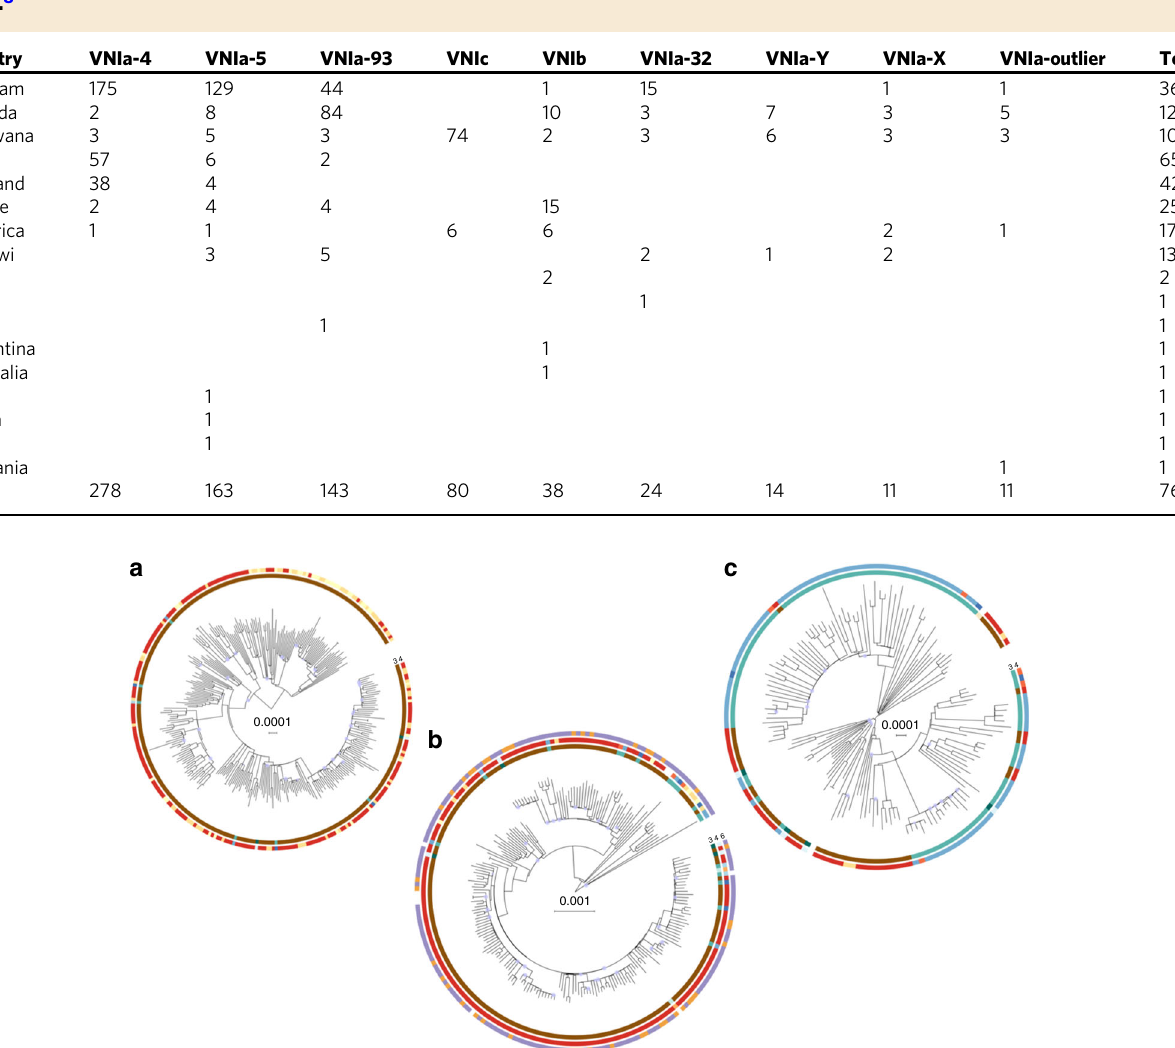
Fig. 2 Within sub-clade phylogenetic trees for a VNIa-4, b VNIa-5 and c VNIa-93. Rings are numbered and coloured according to Fig. 1. Nodes with <80% bootstrap support are denoted with blue circles. Trees were constructed from 24,956 (VNIa-4), 22,894 (VNIa-5) and 11,056 (VNIa-93) variable positions. Scale bar is genetic distance in number of substitutions per